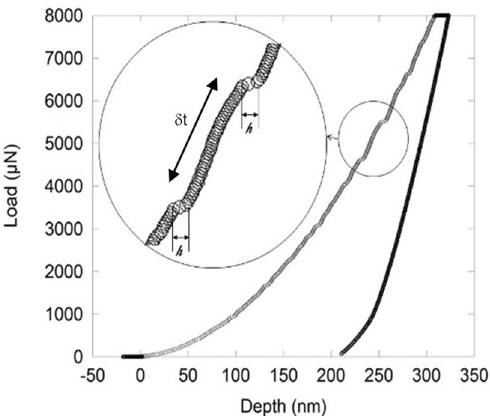
Figure 2. Nano-indentation curve showing serrations on the loading branch, also shown in the inset with the serration size, h and the waiting time between successive serrations δ t .